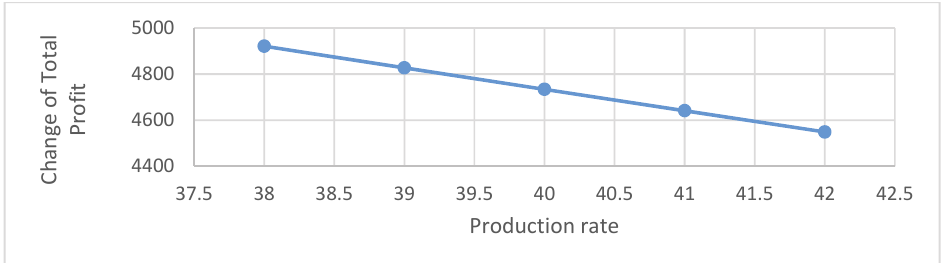
Fig. 8. Effect of production rate on total profit of the inventory